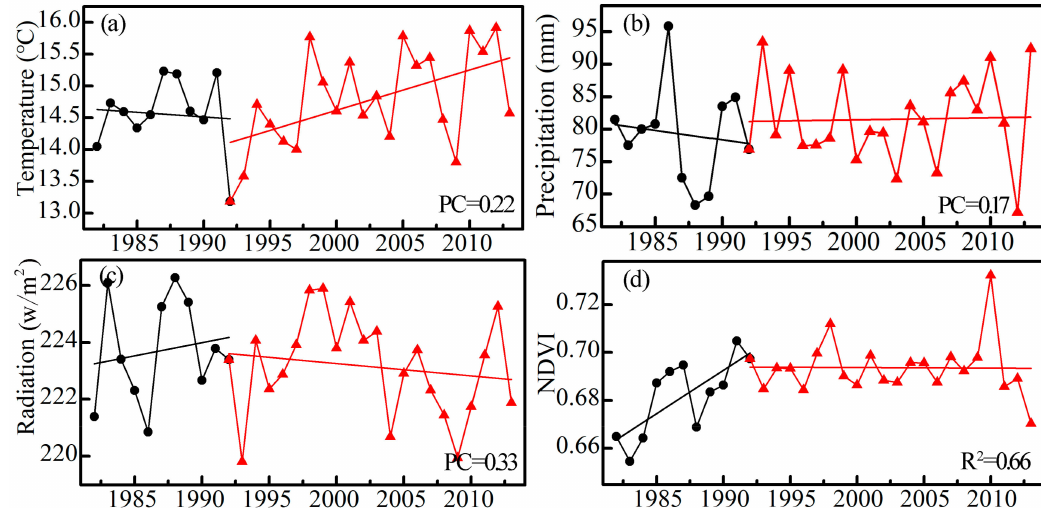
Figure 9. Climatic factors and NDVI variations in eastern North America (ENA) from 1982–2013. ( a ) temperature (T); ( b ) precipitation (P); ( c ) radiation (R); and ( d ) NDVI; the black line and the red line represent the changing trends before and after the temperature change. PC represents the partial correlation coefficient of each climatic factor with NDVI, excluding the other two meteorological variables, and R 2 represents the coefficient of determination between the NDVI and the meteorological factors. The relationship between NDVI and the climate factors is NDVI = 0.01T + 0.00026P − 0.002R +